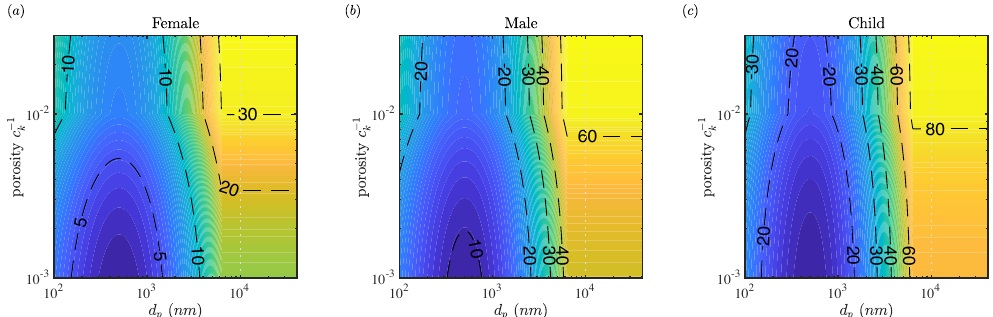
Figure 8. The fitted filtration efficiency FFE as a function of porosity and particle size for ( a ) female face, ( b ) male face, and ( c ) child